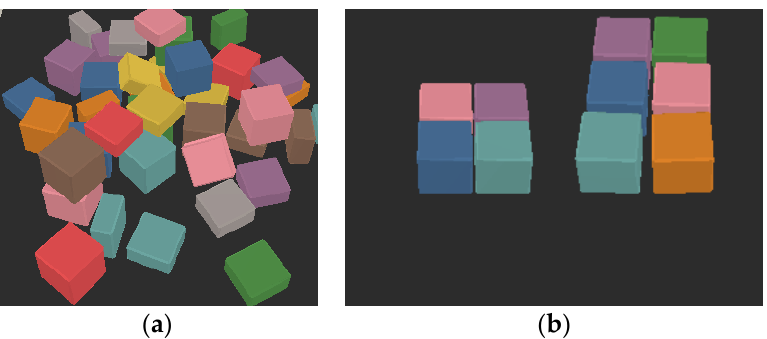
Figure 4. Common object manipulation scenarios in clutter: ( a ) random cluttered scenario (RCS); and ( b ) well-arranged scenario (WAS).